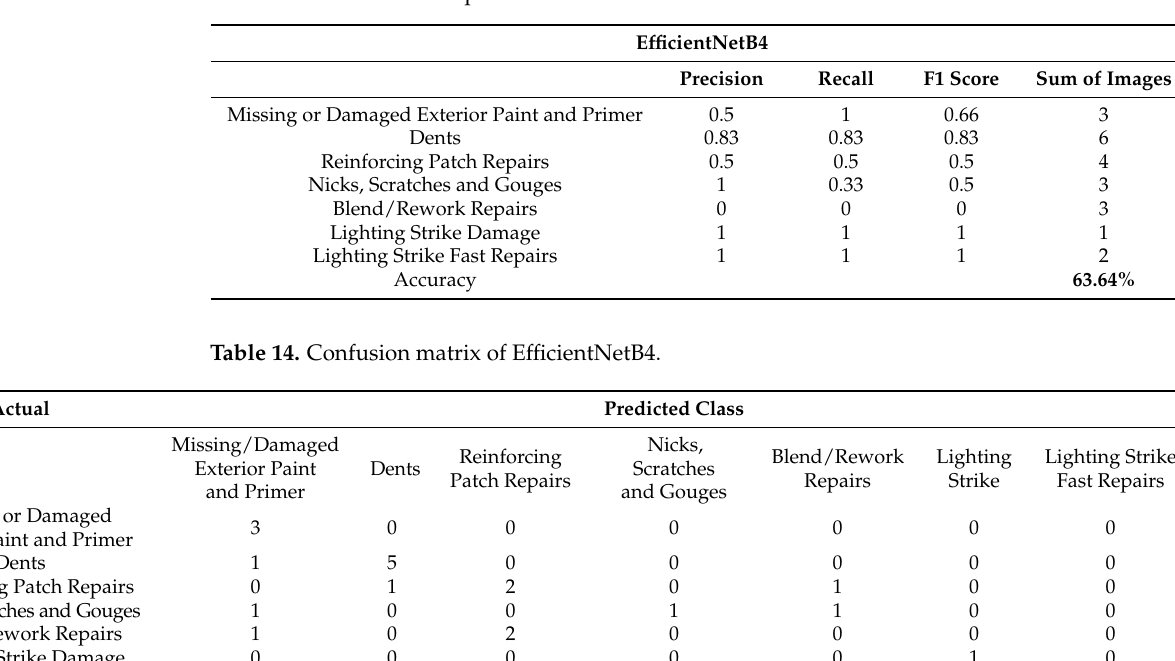
Table 13. Classification report of EfficientNetB4 for defect classification.